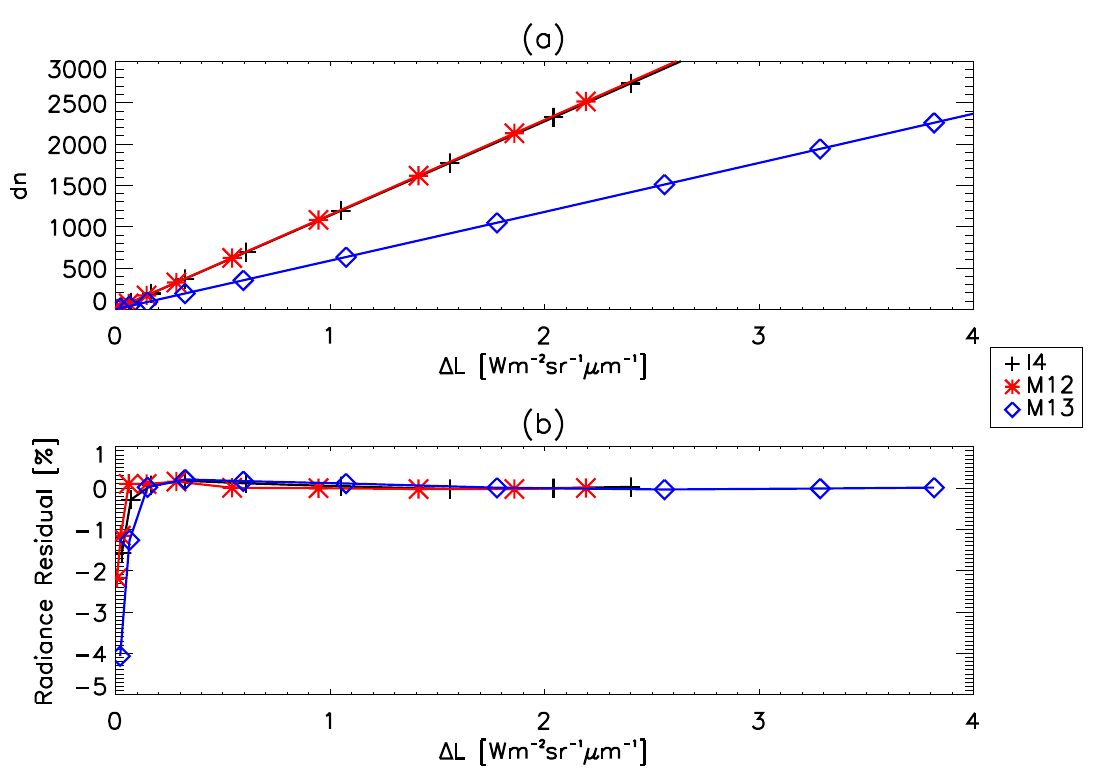
Figure 2. The offset corrected detector response ( a ) and the radiance residual in % ( b ) shown versus path difference radiance. The symbols in ( a ) represent measured data and the lines indicate quadratic fits. The measured data was taken from nominal plateau, HAM side A, electronics side A, FPA temperature 80.5 K using detector 9 (BCS